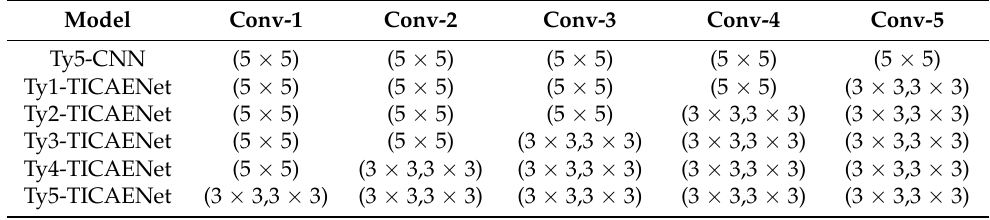
Table 3. Convolution kernel parameters of various